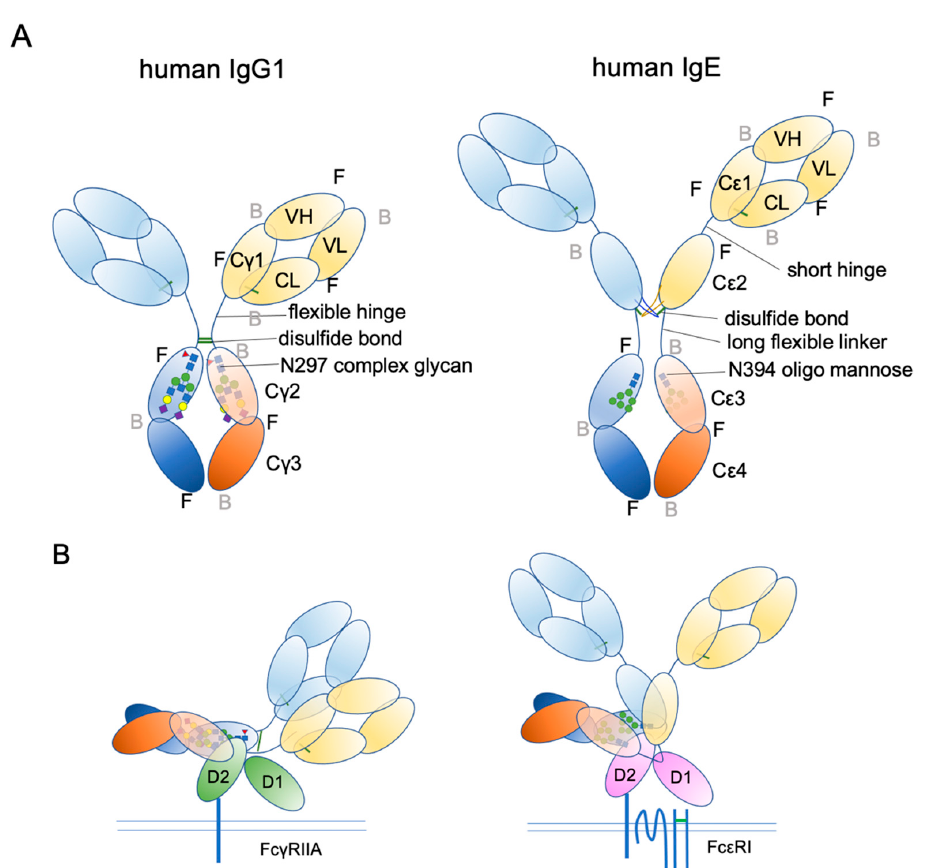
Figure 3. Schematic representation of human IgG1 and IgE. ( A ) The extended conformations. The three-dimensional coordination (front or back) is shown. F, front; B, back. ( B ) The receptor bound conformations. Please note that IgE Fab is almost in the upright position, suitable for sensing its target antigens.